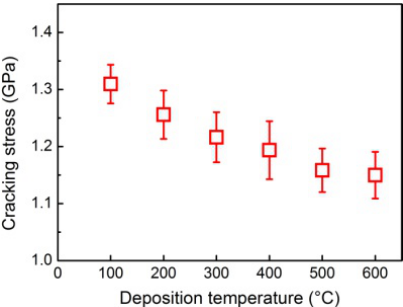
Fig. 8 Cracking stress during splat deposition estimated on the base of Eq.